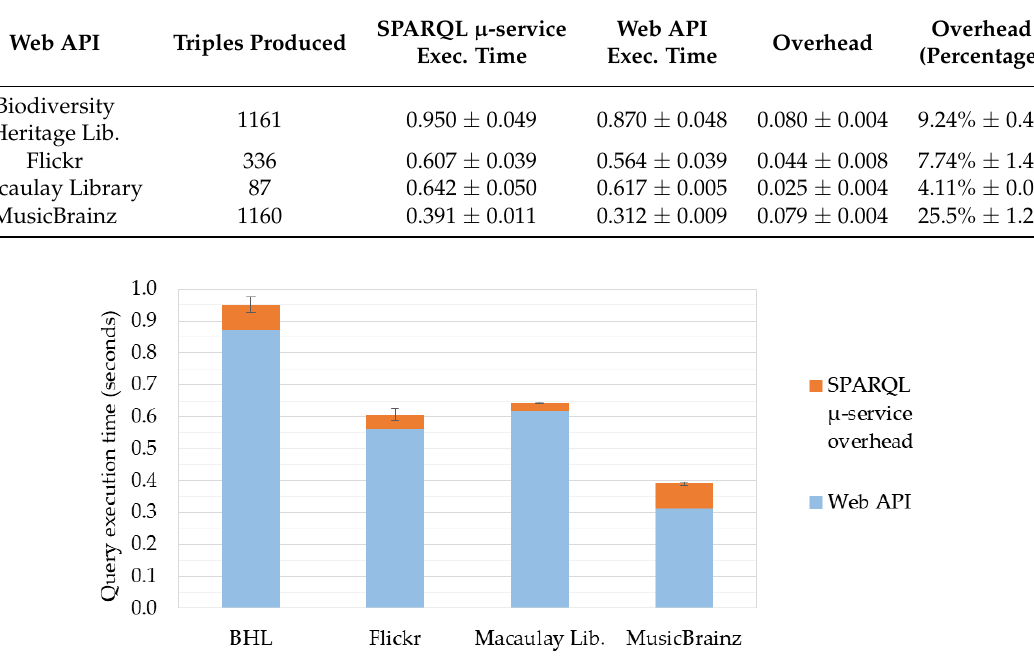
Table 1. Cache-less query execution time (in seconds) against a SPARQL micro-service. The last column is the overhead (in %) imposed by the SPARQL micro-service compared to a direct Web API query.